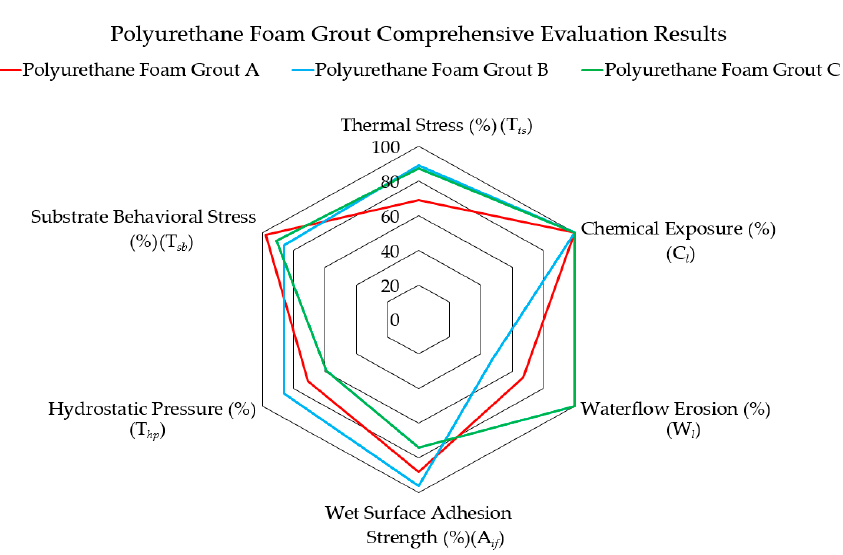
Figure 15. The physical property changes of the polyurethane-foam grout-injection material.